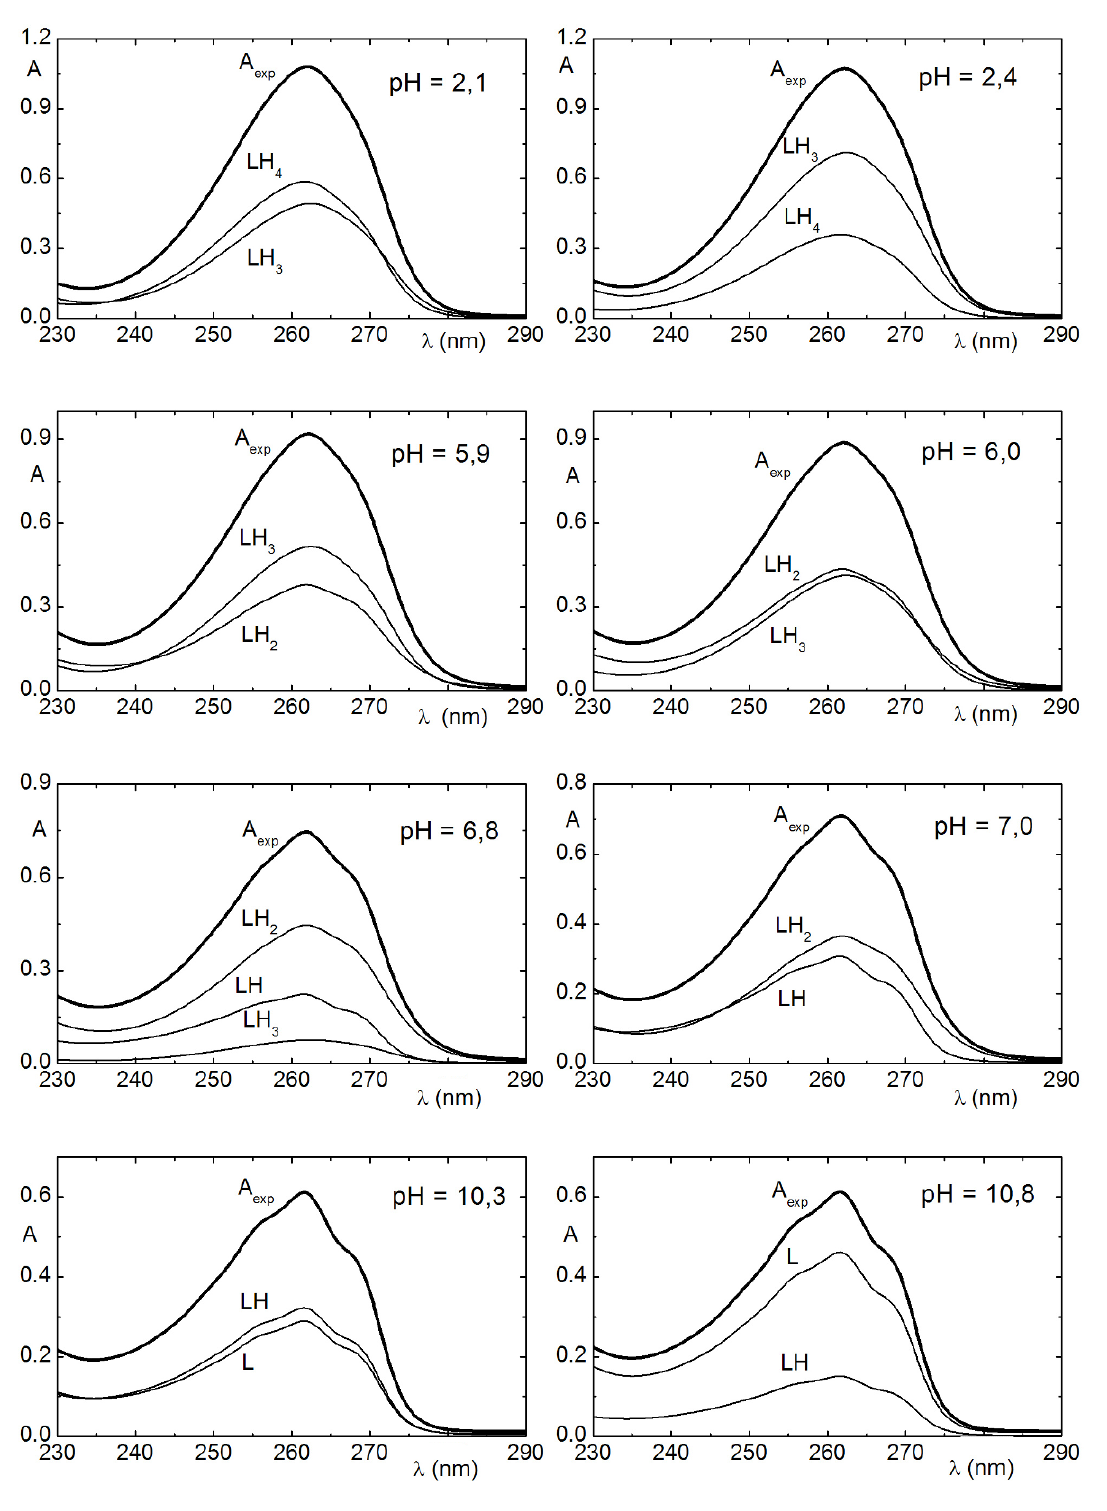
Figure 5. Deconvolution of the experimental absorption spectrum of risedronate for 39 wavelengths into spectra of the individual variously protonated species L, LH, LH , LH and LH in solution of each particular absorption spectrum for a selected value of pH equal 2.1, 2.4, 2 3 4 5.9, 6.0, 6.8, 7.0, 10.3, 10.8. The charges of species are omitted for the sake of simplicity (SQUAD,